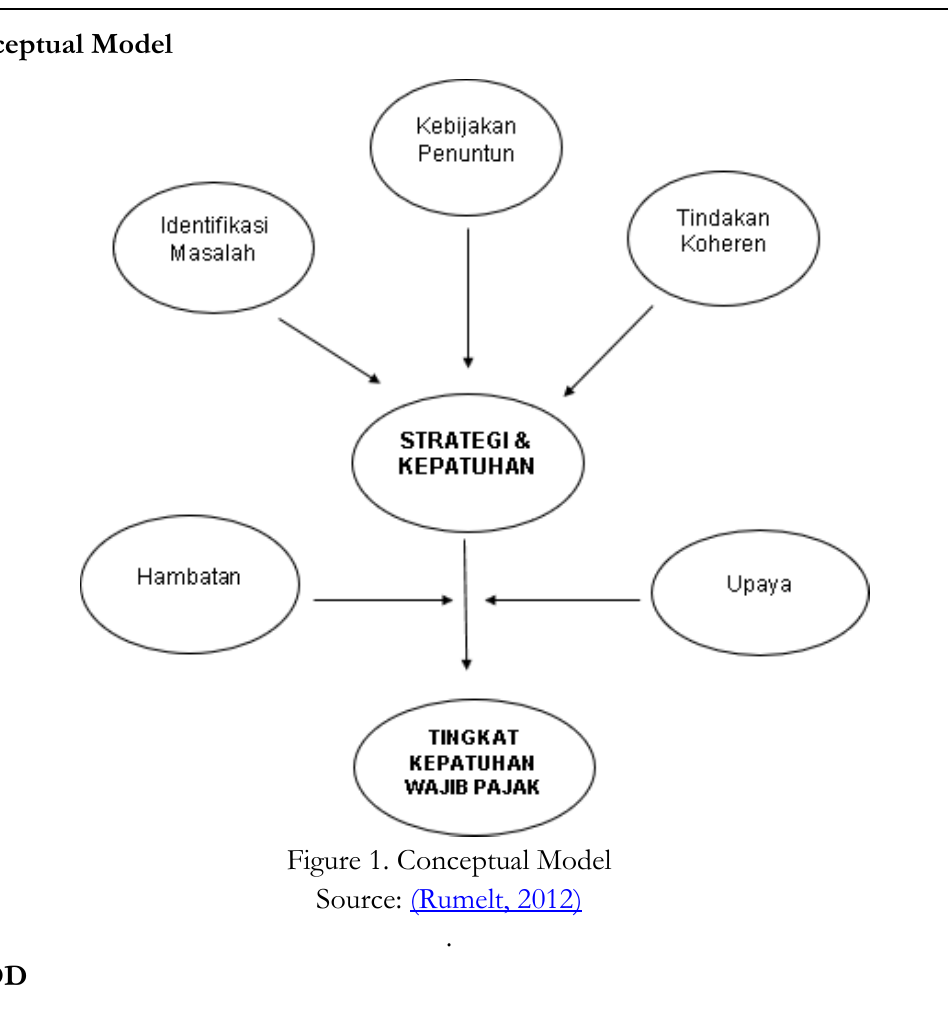
Figure 1. Conceptual Model Source: (Rumelt, 2012)